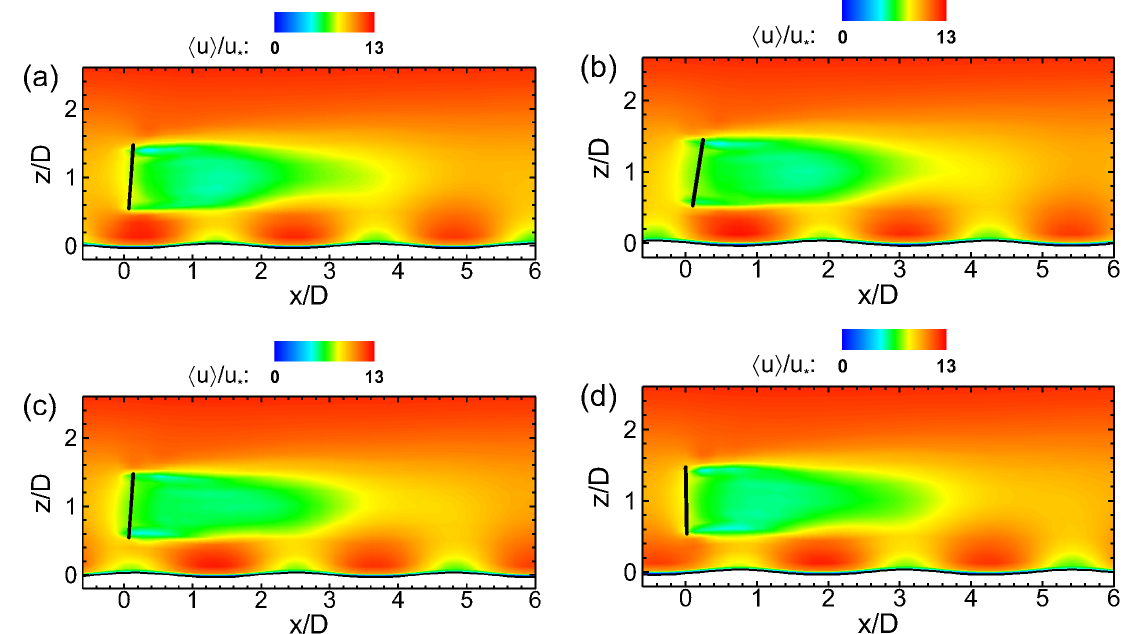
Figure 4. Swell-phase averaged streamwise wind velocity (cid:104) u (cid:105) at four representative swell phases for pitching-turbine case: ( a ) trough (Phase 1); ( b ) forward slope (Phase 2); ( c ) crest (Phase 3); and ( d ) backward slope (Phase 4). Turbine-rotor-disk location indicated by thick black line.